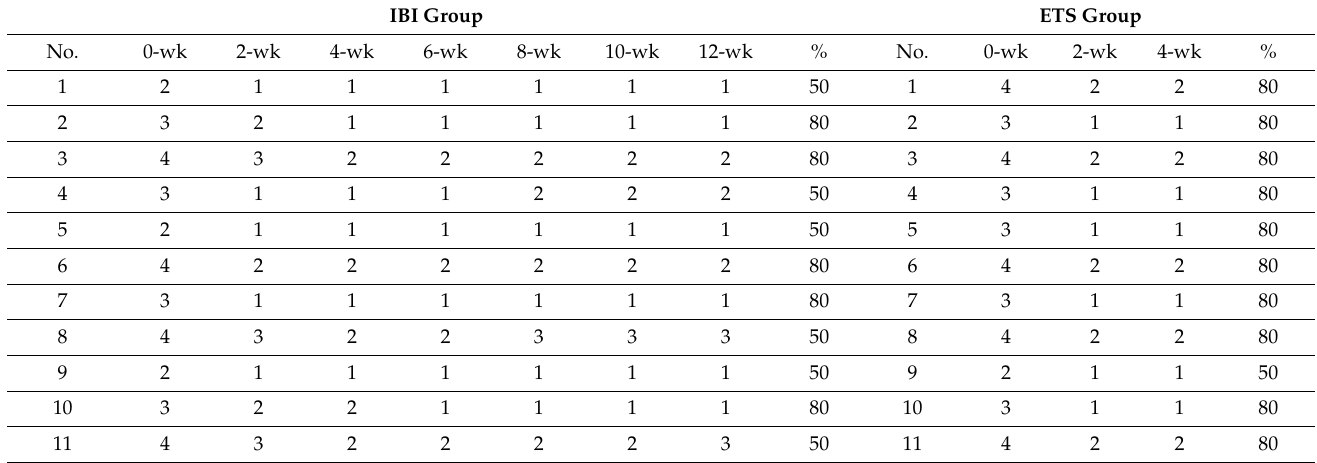
Table 2. Individual HDSS scores and the percentage score change at end of the 12-week